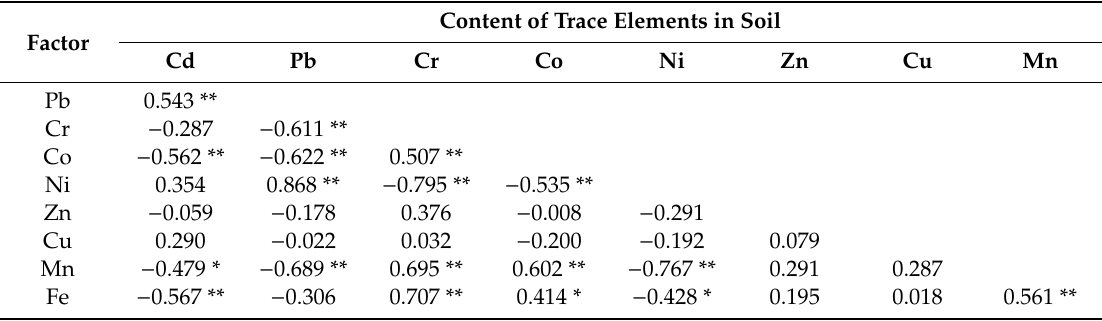
Table 4. Pearson’s correlation coe ffi cients (r) between content of trace elements in soil. Factor